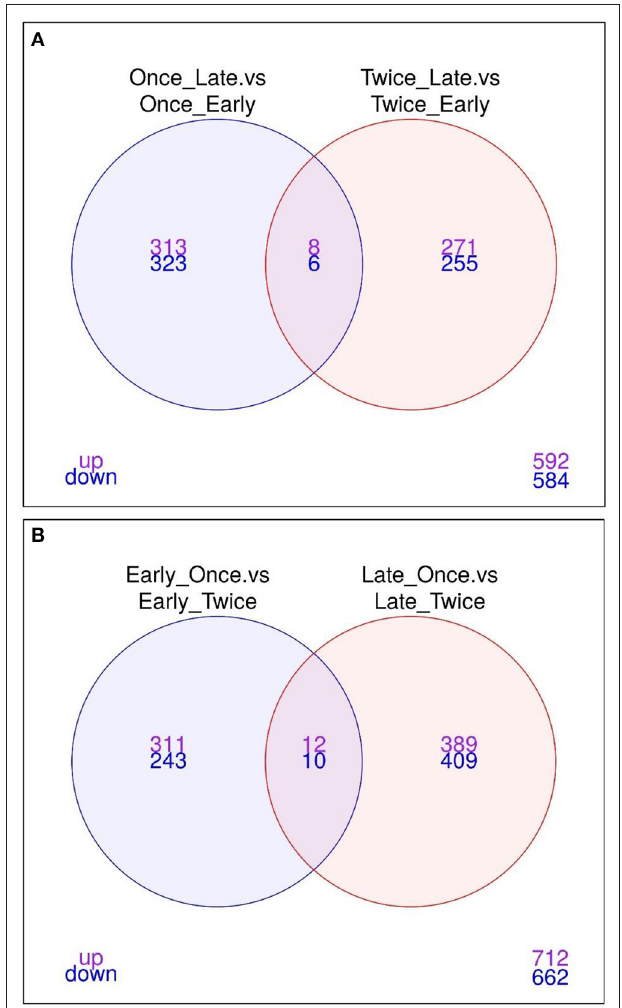
FIGURE 5 | Venn diagram illustrating the upregulation and downregulation of loci between different comparisons. The Venn diagrams illustrate the core genes for (A) “Once sheared and late pregnancy vs. once sheared and early pregnancy” as well as in “Twice sheared and late pregnancy vs. twice sheared and early pregnancy” (B) Early pregnancy and once sheared vs. early pregnancy and twice sheared as well as late pregnancy and once sheared vs. late pregnancy and twice sheared sheep. Only features with a FDR < 0.05 and logFC > 0 were